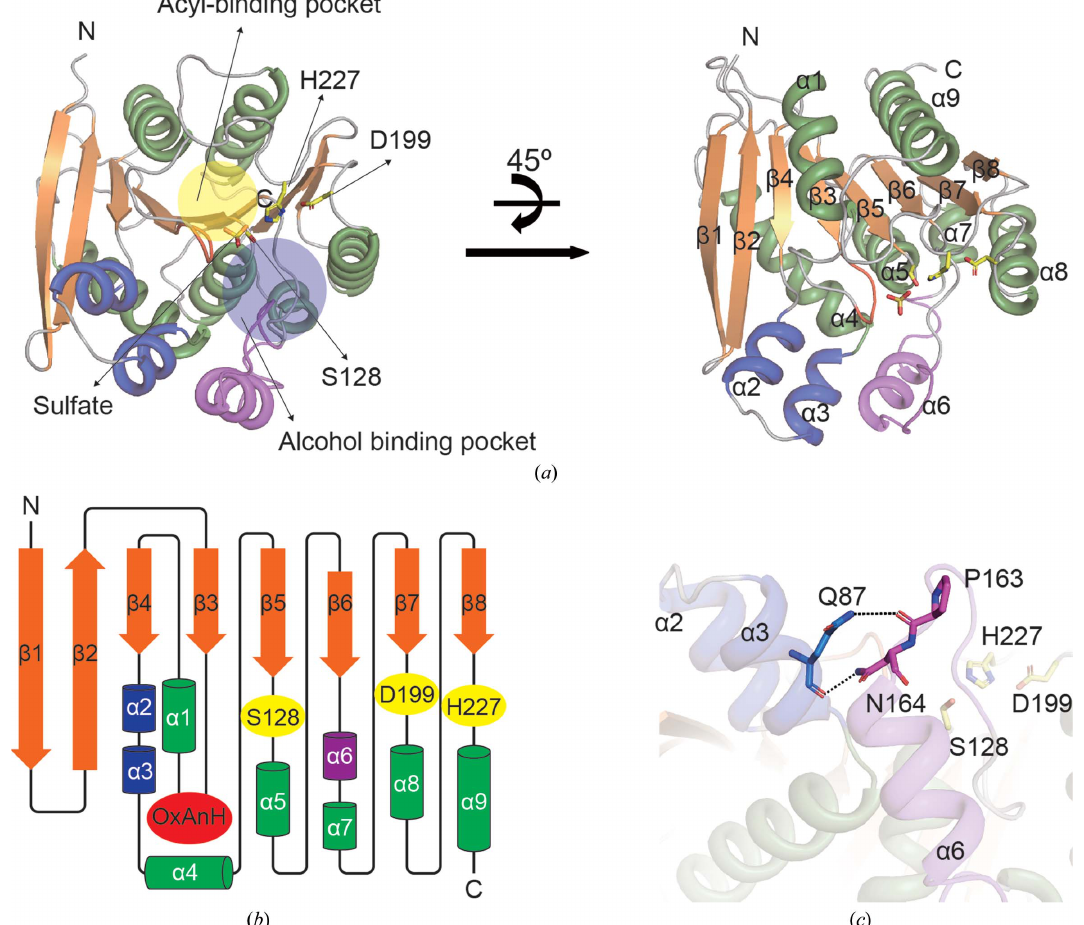
Figure 1 Overall structure of PsEst3. Cartoon representation ( a ) and secondary-structure topology ( b ) of PsEst3. (cid:3) -Helices and (cid:2) -sheets are represented as coils and arrows, respectively. A sulfate ion and the catalytic triad (Ser128, Asp199 and His227) are represented as yellow sticks. The tetrapeptide for an oxyanion hole (red) and a PsEst3-specific region (blue and magenta) are highlighted. ( c ) Residues participating in the inter-motif interaction between (cid:3) 3 and (cid:3) 6 of PsEst3 are shown as stick